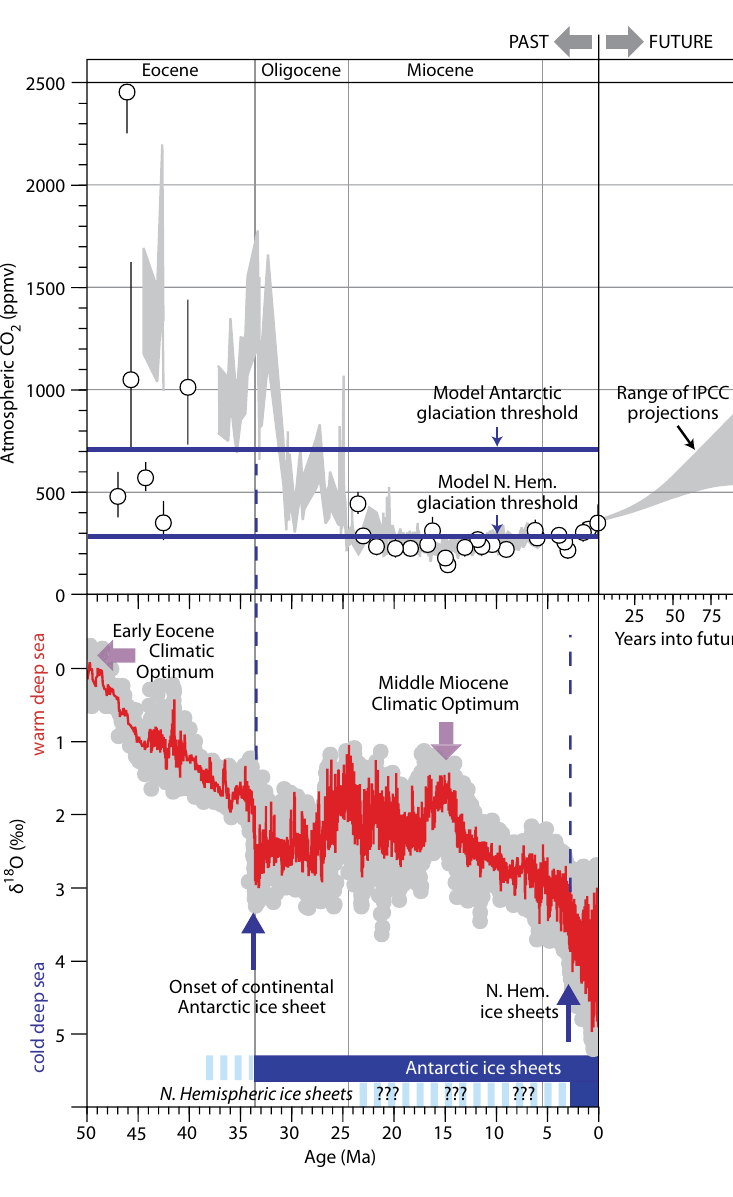
figure 2.2. a summary of co 2 and climate indicators spanning the last 50 million years. Blue along lower axis shows inferred presence/absence of north and south polar ice sheets. The benthic marine δ 18 o record (red line; Zachos et al., 2001), an indicator of deep-ocean and high-latitude surface ocean temperatures, illustrates the long-term global cooling that has occurred over the last 50 million years. over this same time period, proxy indicators suggest that atmospheric co 2 (top panel) may have periodically exceeded 1000 ppmv prior to 35 mil- lion years ago. These estimates are derived from stable carbon isotope values of alkenones found in deep-sea sediment cores (gray band; pagani et al., 2005) and estimates from boron isotope-ph reconstructions (open circles; pearson et al., 1999). model-derived co 2 - glaciation thresholds for antarctica and the northern hemisphere (deconto et al., 2008) are shown for com- parison with the geologic record. future ipcc projections of rising co 2 over the next century fall within the range inferred for the earlier cenozoic, illustrating the long-term context that only ocean drilling can